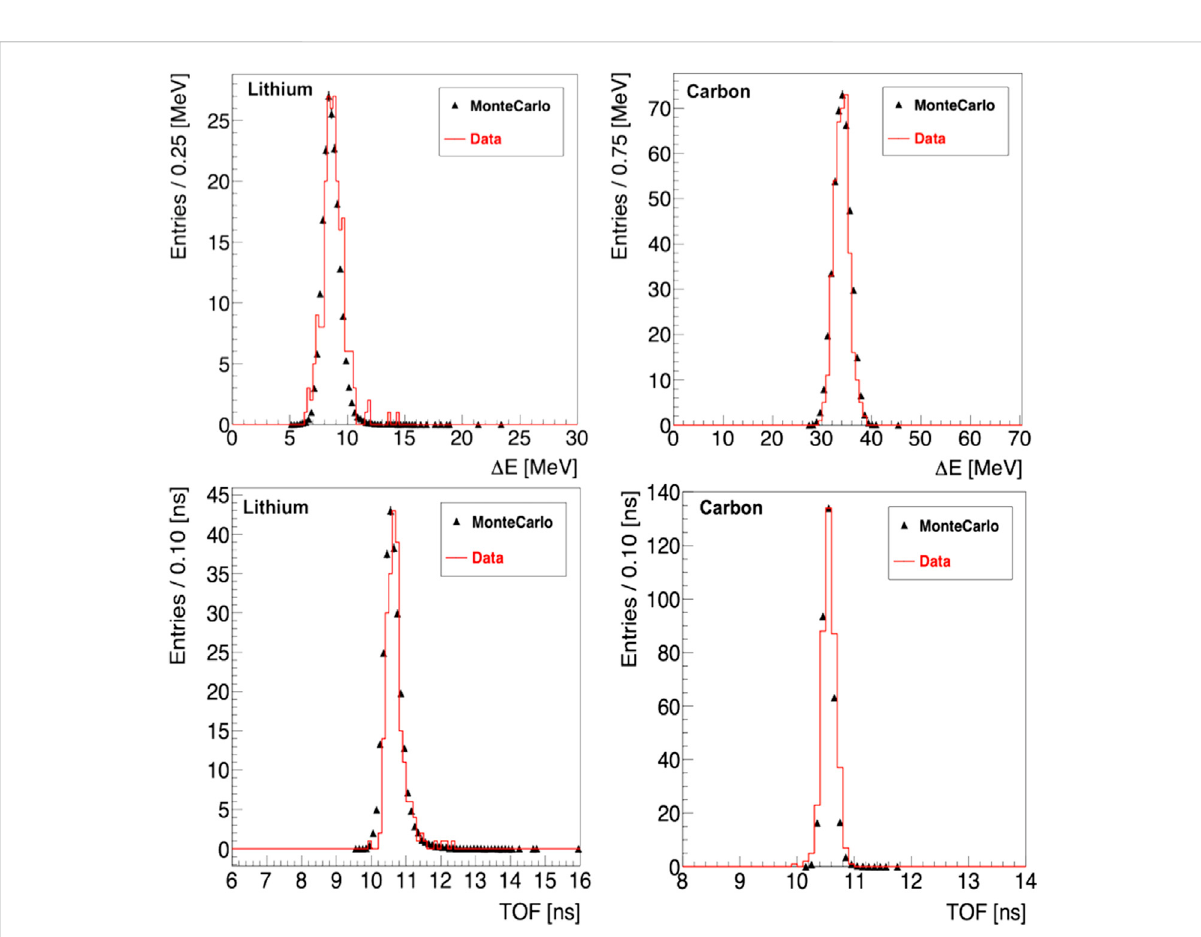
FIGURE 7 Comparison of Δ E and TOF extracted from GSI data and Δ E and TOF extracted from the MC simulations of a 16 O beam at 400 MeV/u on a C target, for Z = 3 and Z = 6. The MC distributions have been normalized to the peak of the data